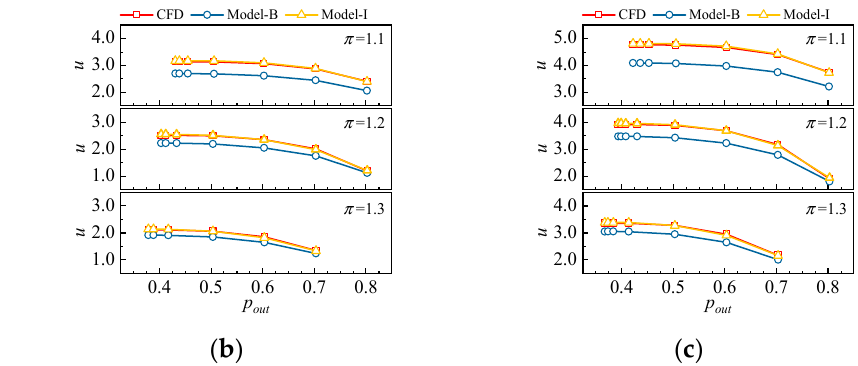
Figure 9. The validation of injection characteristics of the improved VABI model: ( a ) A VABI = 0.8; ( b ) A VABI = 0.6; ( c ) A VABI = 0.4.